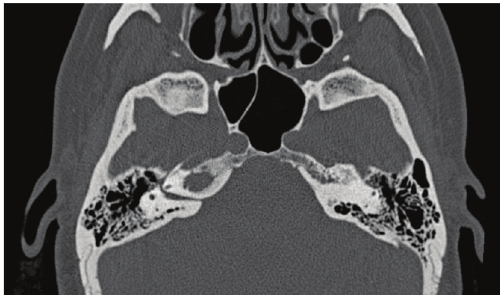
Figure 4: Axial CT scan showes an osteolytic lesion involving the right petrous